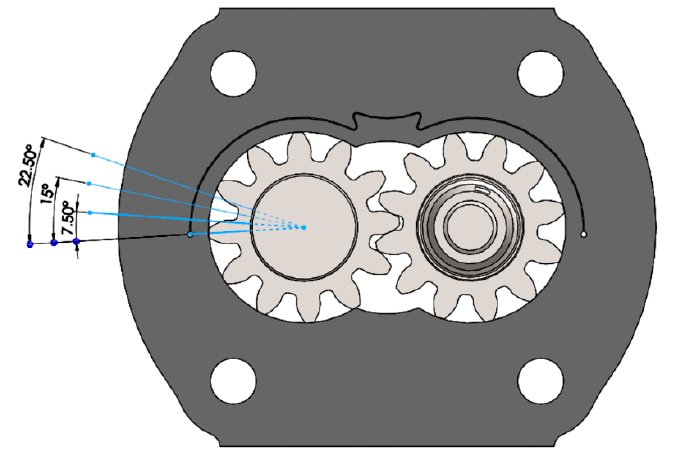
Figure 6. Geometric model of casing A with straight teeth, with four indicated compensation lip support points included in the calculations.